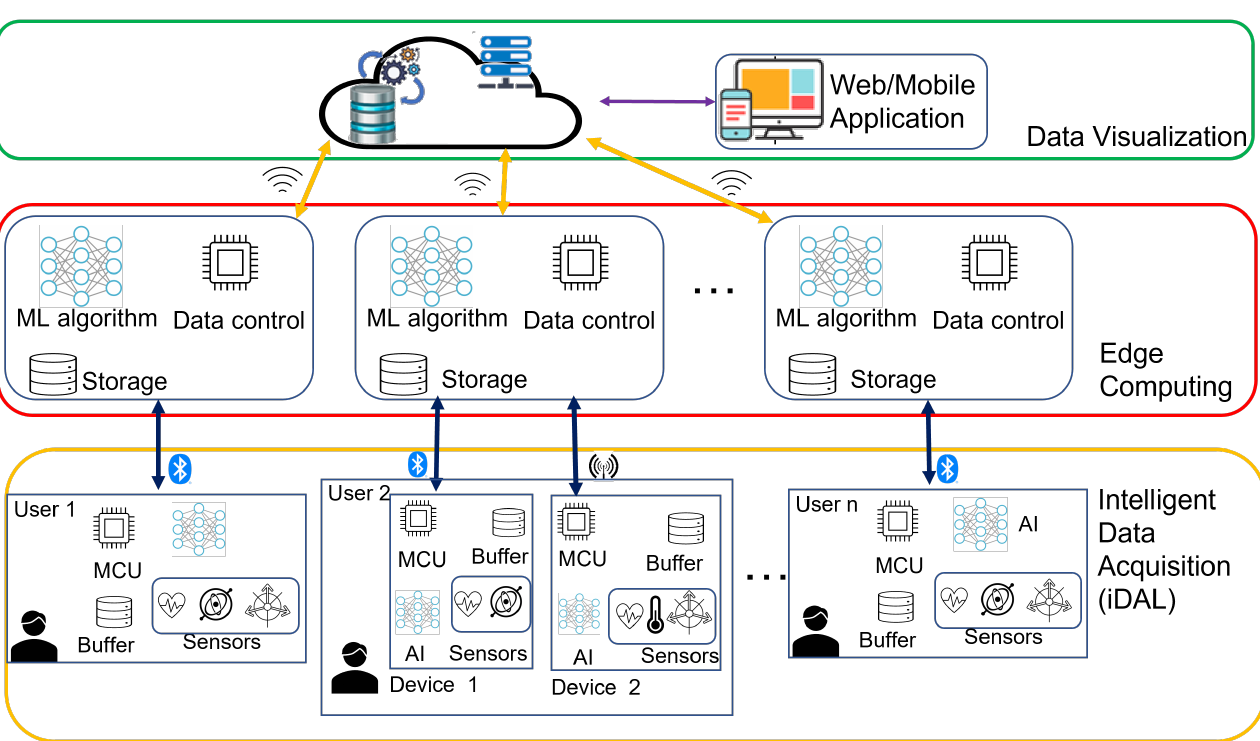
Figure 2. Proposed system architecture.